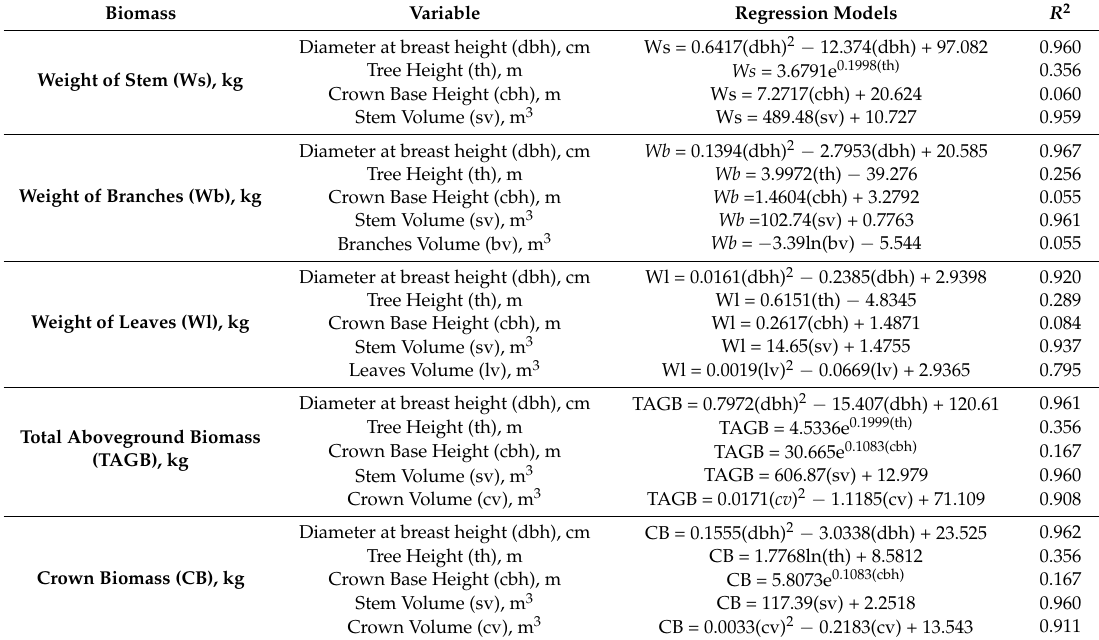
Table A1. Allometric equation generated for Akasia with tree variables obtained from TLS. Biomass